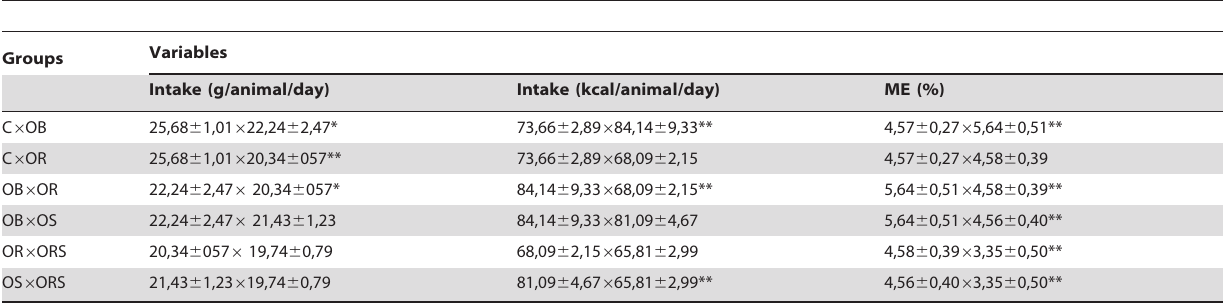
Table 2. Nutritional information: food intake (g), calorie intake (kcal) and metabolic efficiency (ME).